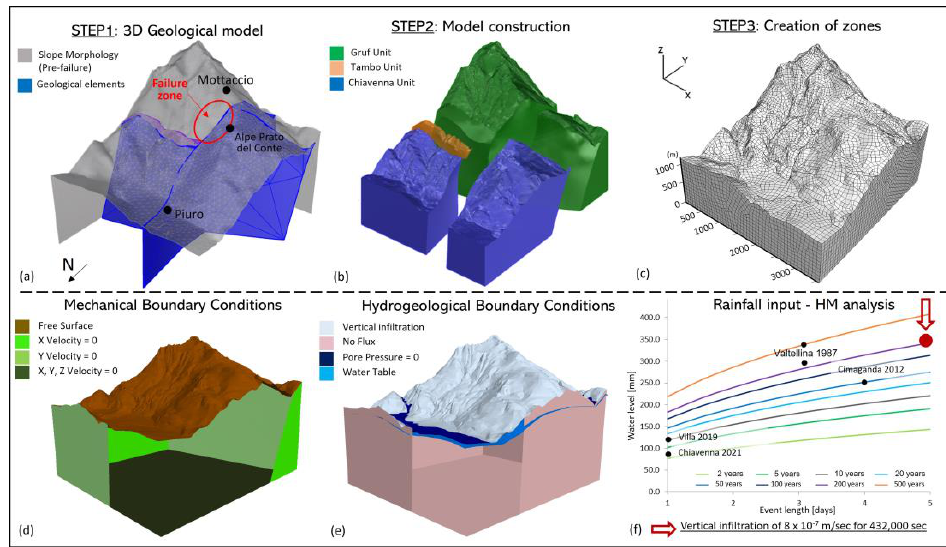
Figure 4. ( a ) 3D geological model built starting from the geological – structural features of the slope presented in Figure 1d; ( b ) FLAC3D model building; ( c ) Discretization into a finite-difference